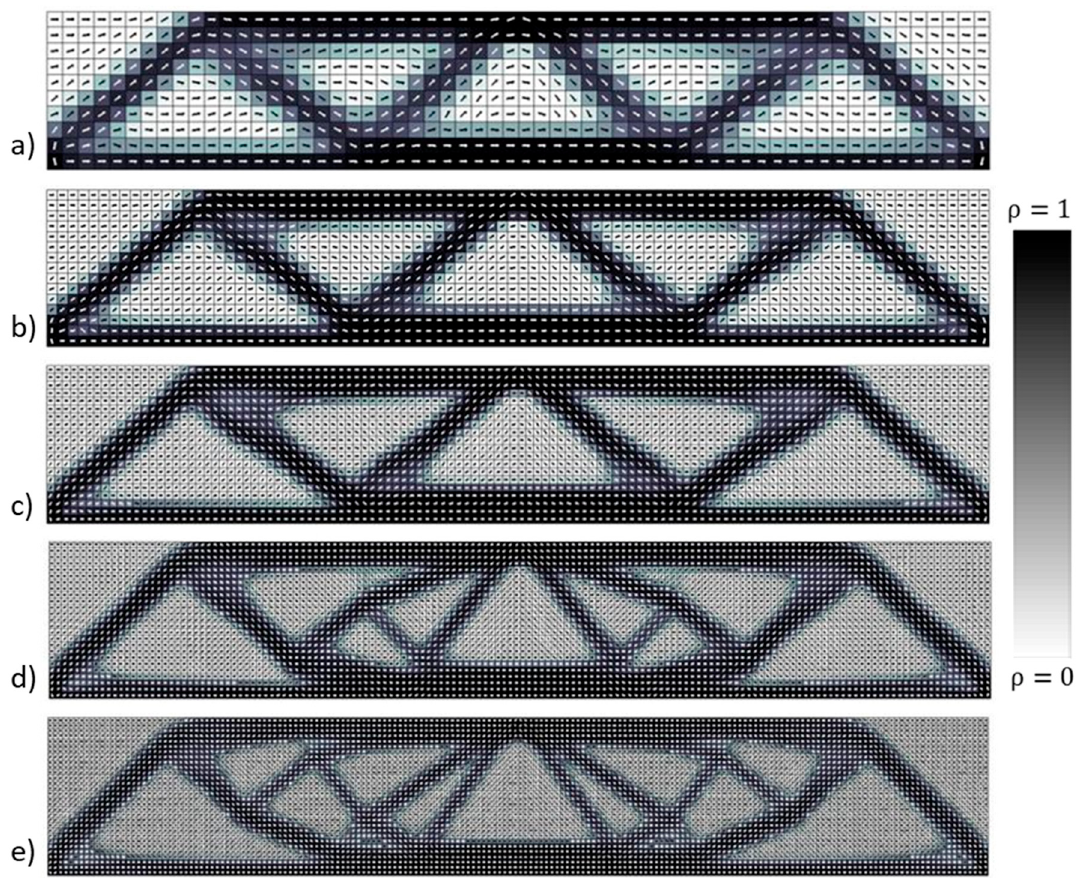
Figure 5. CFAO optimization of MBB beam using various mesh sizes: ( a ) 60 × 10 elements, ( b ) 90 × 15 elements, ( c ) 120 × 20 elements, ( d ) 150 × 25 elements, and ( e ) 180 × 30 elements.